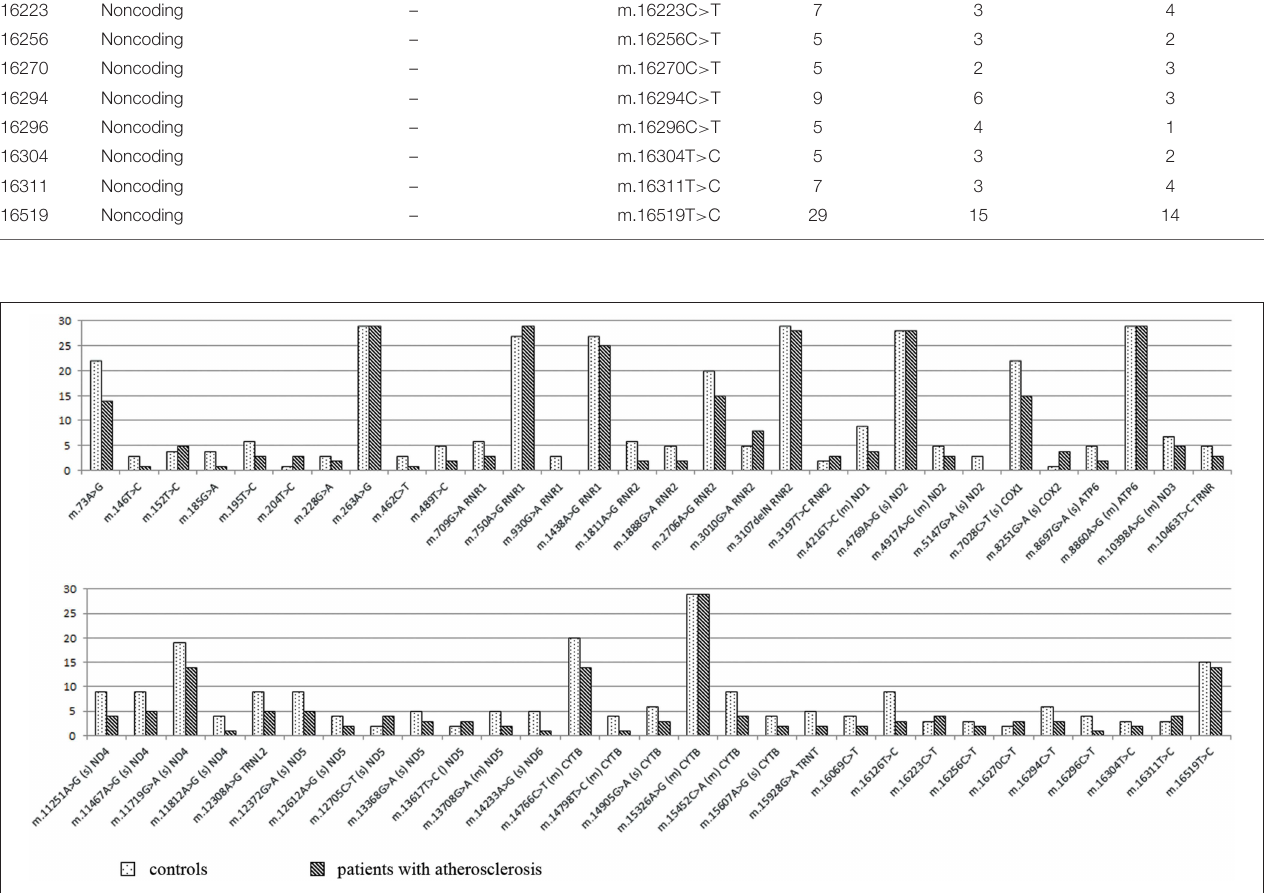
FIGURE 1 | Frequency of the most common homoplasmic mtDNA mutations. For single nucleotide substitutions in coding region there is a designation of the character of mutation (s, synonymous; m, missence), and corresponding